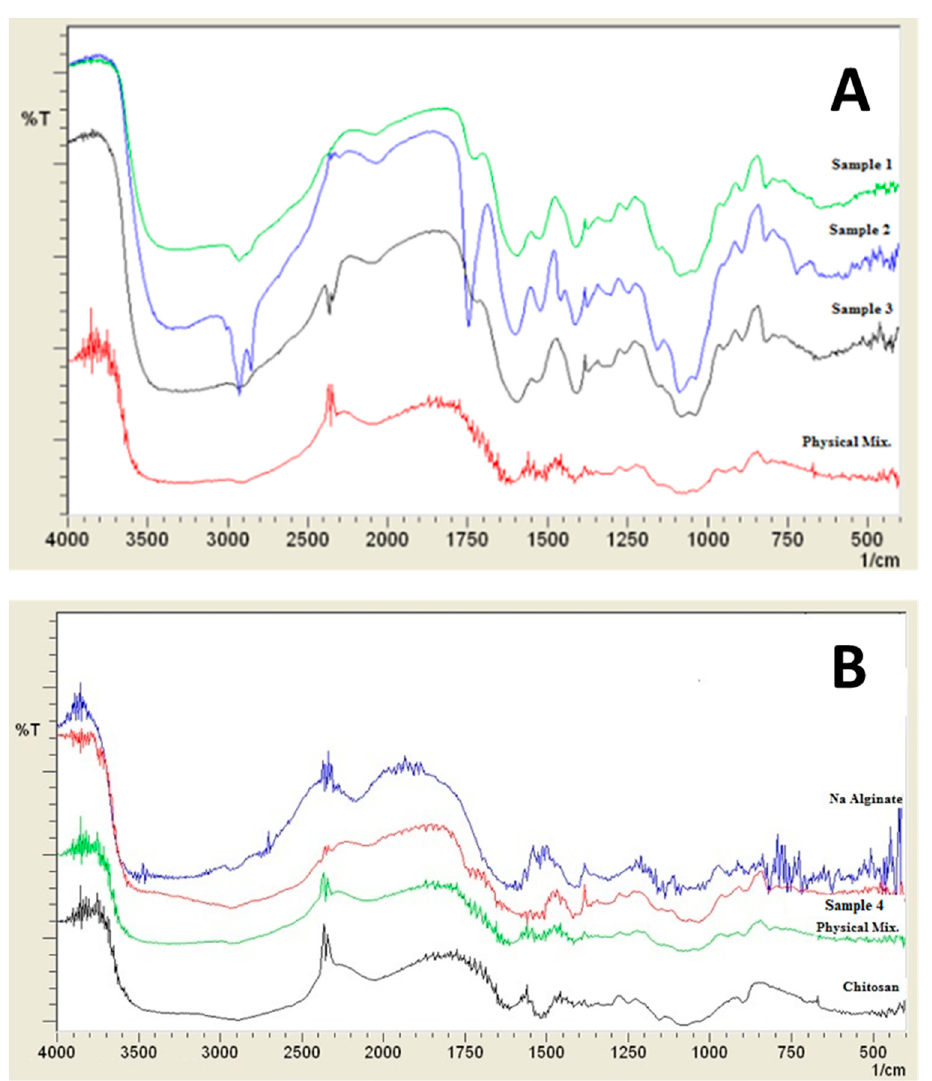
Figure 2. Infra-red spectra of prepared samples ( A ) Samples 1, 2, 3, and their corresponding physical mixture, ( B ) Na alginate, chitosan, sample 4, and its corresponding physical mixture.